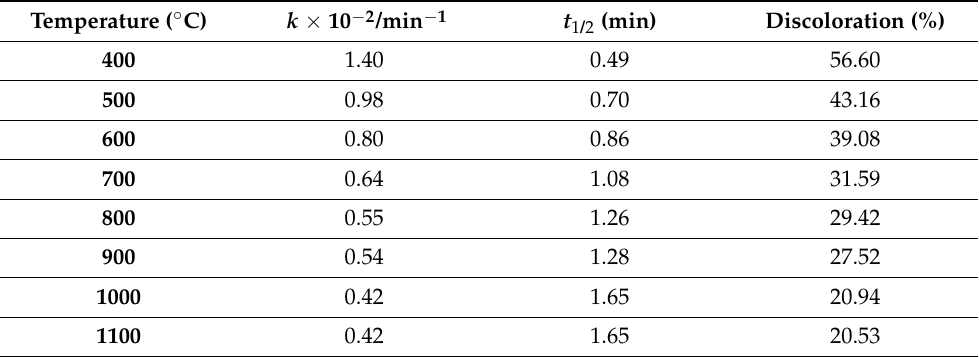
Table 3. The experimental photocatalytic data of the green malachite discoloration solution in the CuFe 2 O 4 heat-treated